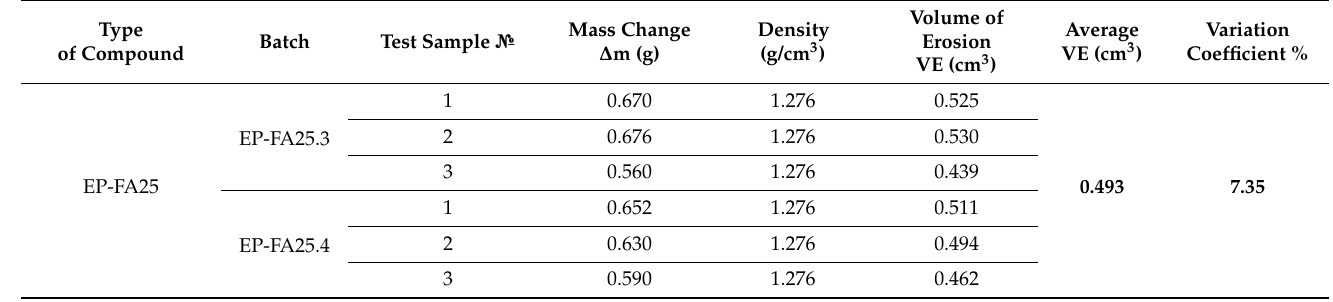
Table A8. Wear of filled epoxy binder (EP-FA25) at 23 ◦ C at an impingement angle of 45 ◦ .